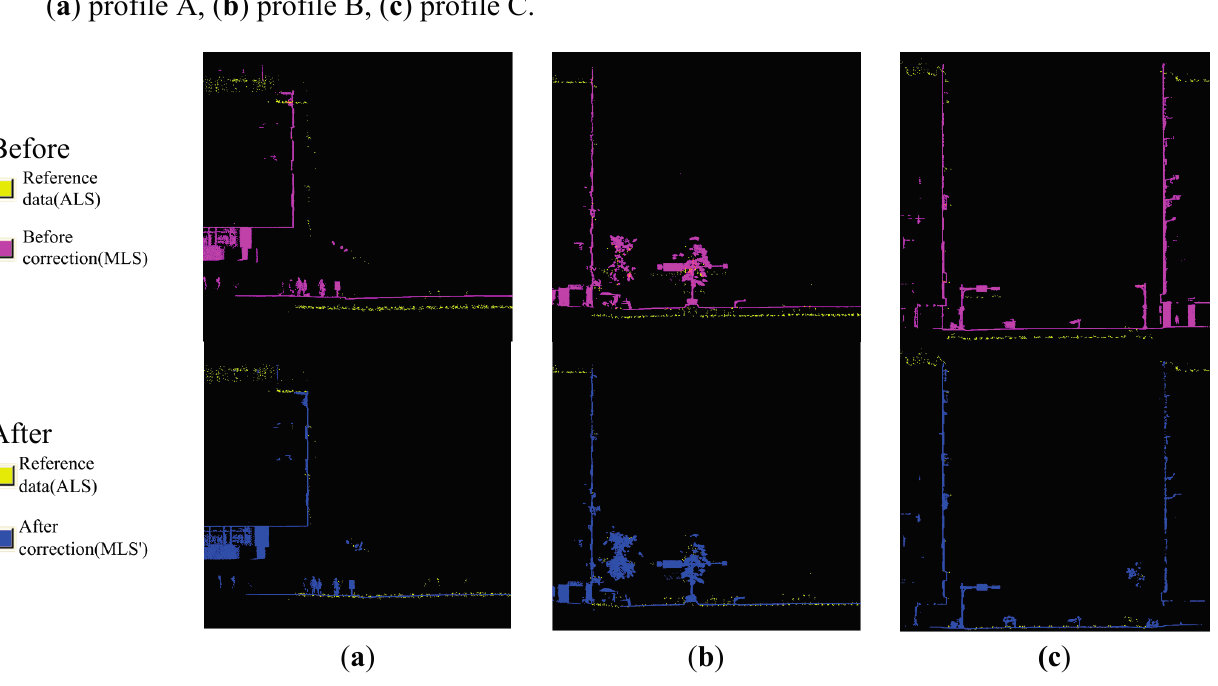
Figure 14. The profiles of the airborne LiDAR and terrestrial mobile LiDAR point cloud: